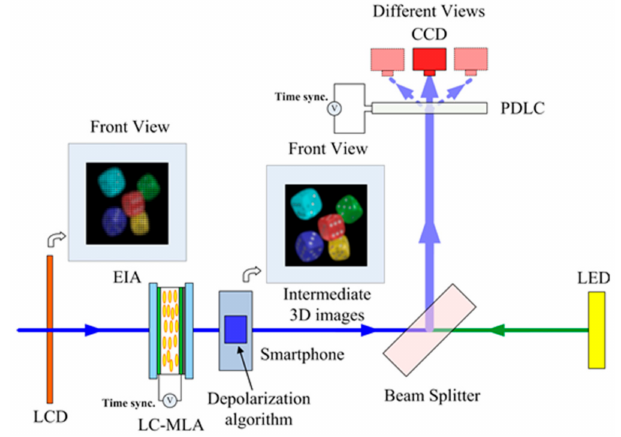
Figure 1. The schematic optical architecture of the proposed light field display